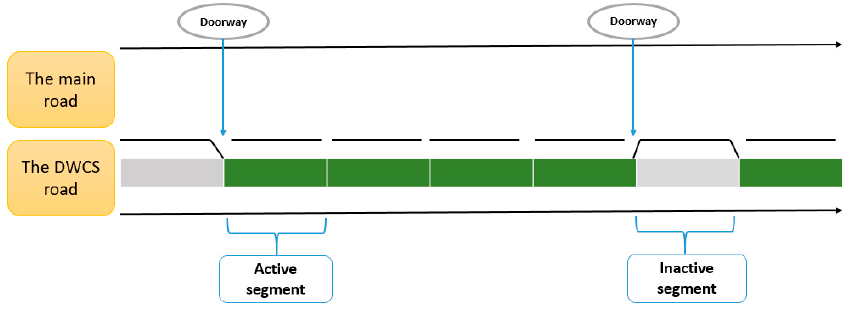
Figure 4. Highway with active and inactive segments.